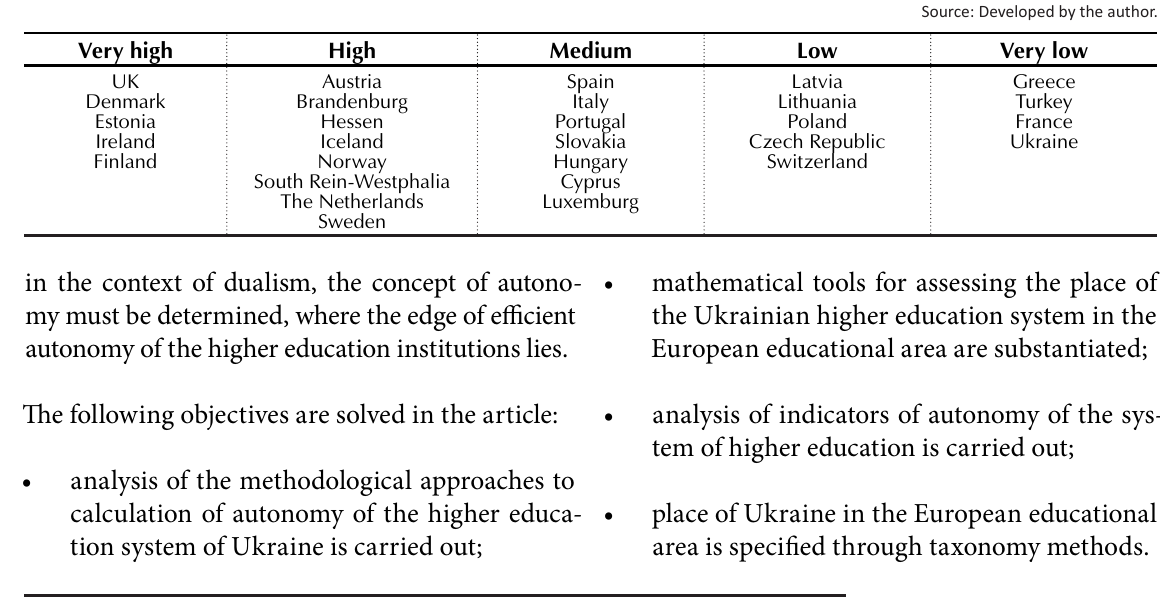
Source: Developed by the author.